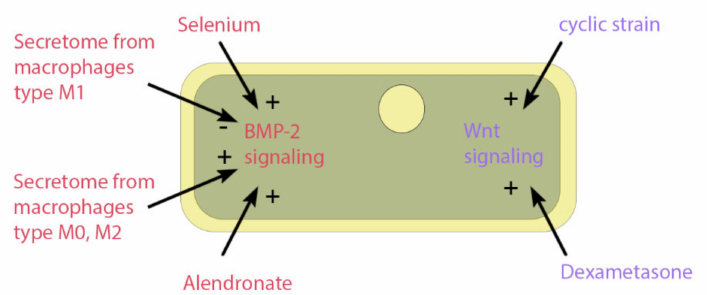
Figure 5. Impact on osteogenic signaling pathways. The figure shows the impact of pharmacological or mechanical stimuli on the osteogenic signaling pathways of BMP-2 or Wnt. The factors include selenium particles, secretome from different phenotypes of macrophages, the drug alendronate, the osteogenic differentiation medium component dexamethasone, and dynamic cell culture through a cyclic